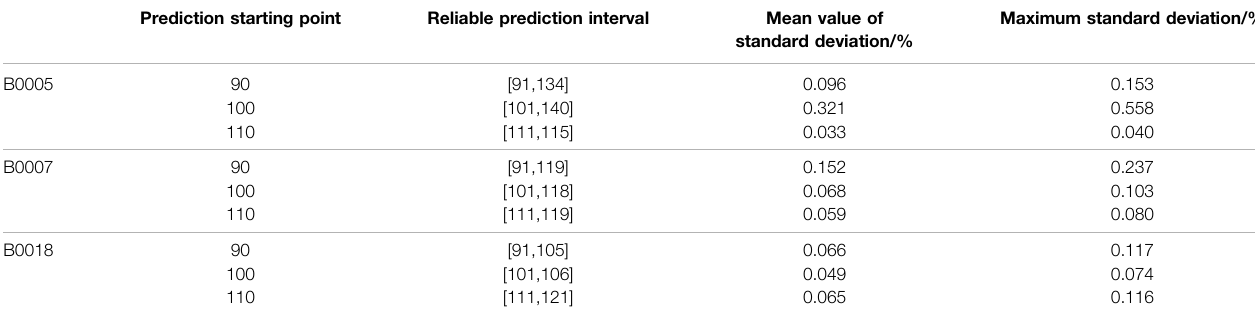
TABLE 5 | Uncertainty expression of SOH prediction results. Prediction starting point Reliable prediction